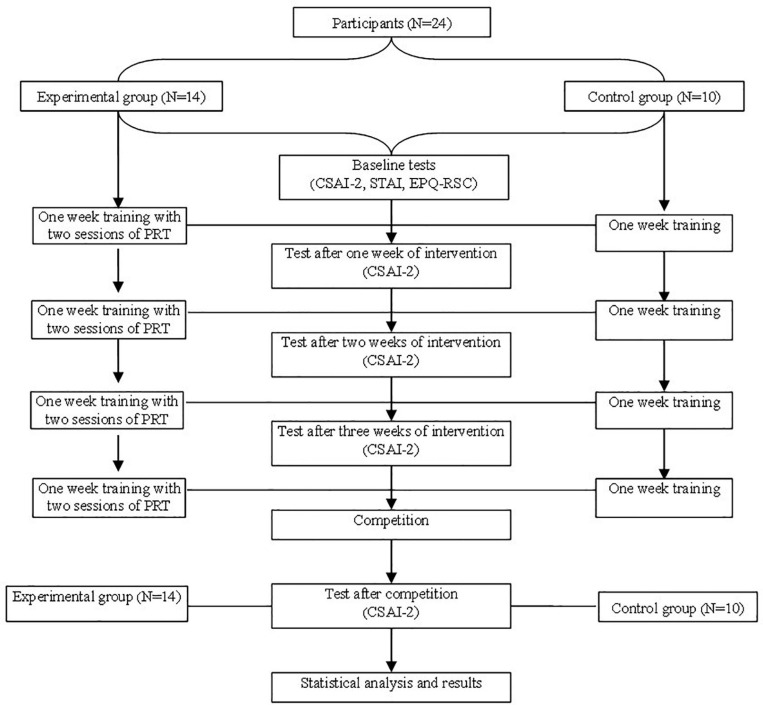
Research procedure.